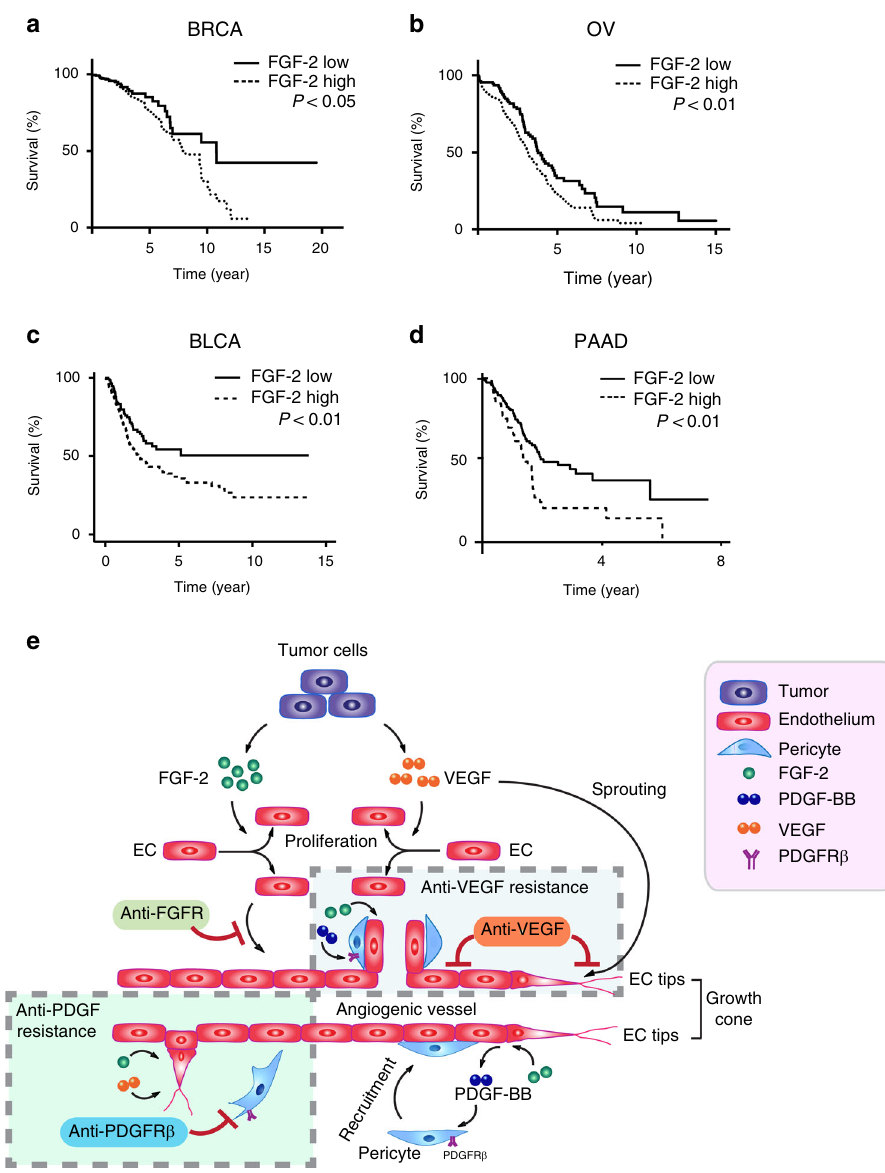
Fig. 7 Survival correlation and schematic diagram of underlying mechanisms of synergistic anti-FGF-2 + tumor activity by combination therapy. a Kaplan – Meier survival of FGF-2-high vs. FGF-2-low breast cancer (BRCA, n = 246 vs. 267; P = 0.0458); b ovarian cancer (OV, n = 131 vs. 129; P = 0.0097); c bladder carcinoma (BLCA, n = 261 vs. 141; P = 0.007); d and pancreatic adenocarcinoma (PAAD, n = 57 vs. 120; P = 0.003). The log-rank